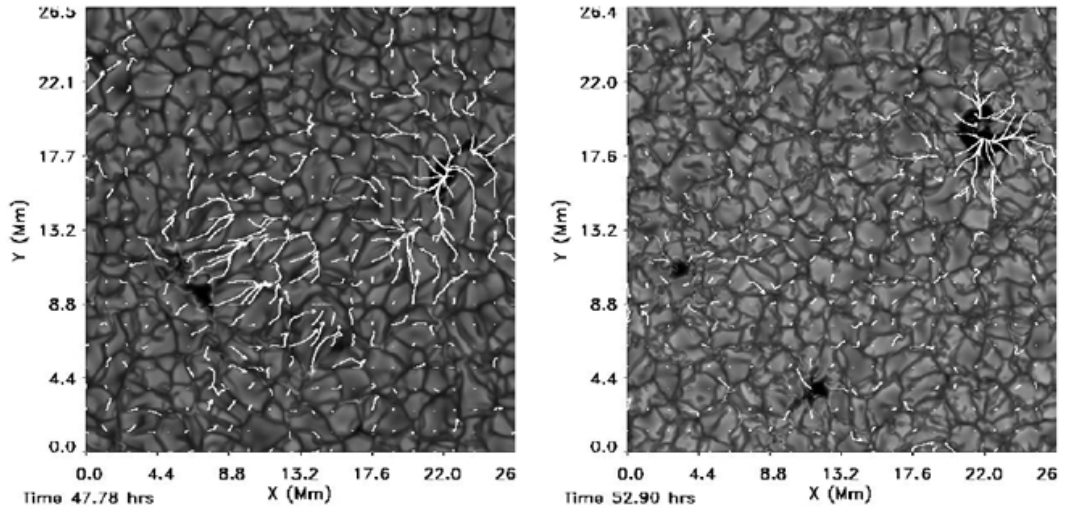
Figure 36: Synthetic brightness images of a simulated emerging flux region. Overlaid are traces along hor- izontal magnetic field vectors at the surface. Image reproduced with permission from Stein and Nordlund (2012), copyright by